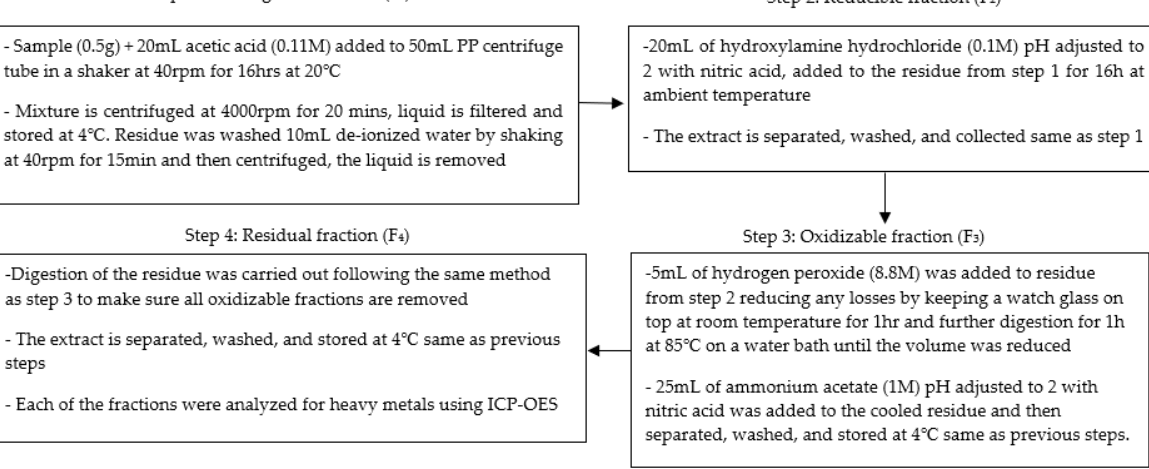
Figure 1. BCR sequential procedure for fractionization of metals.